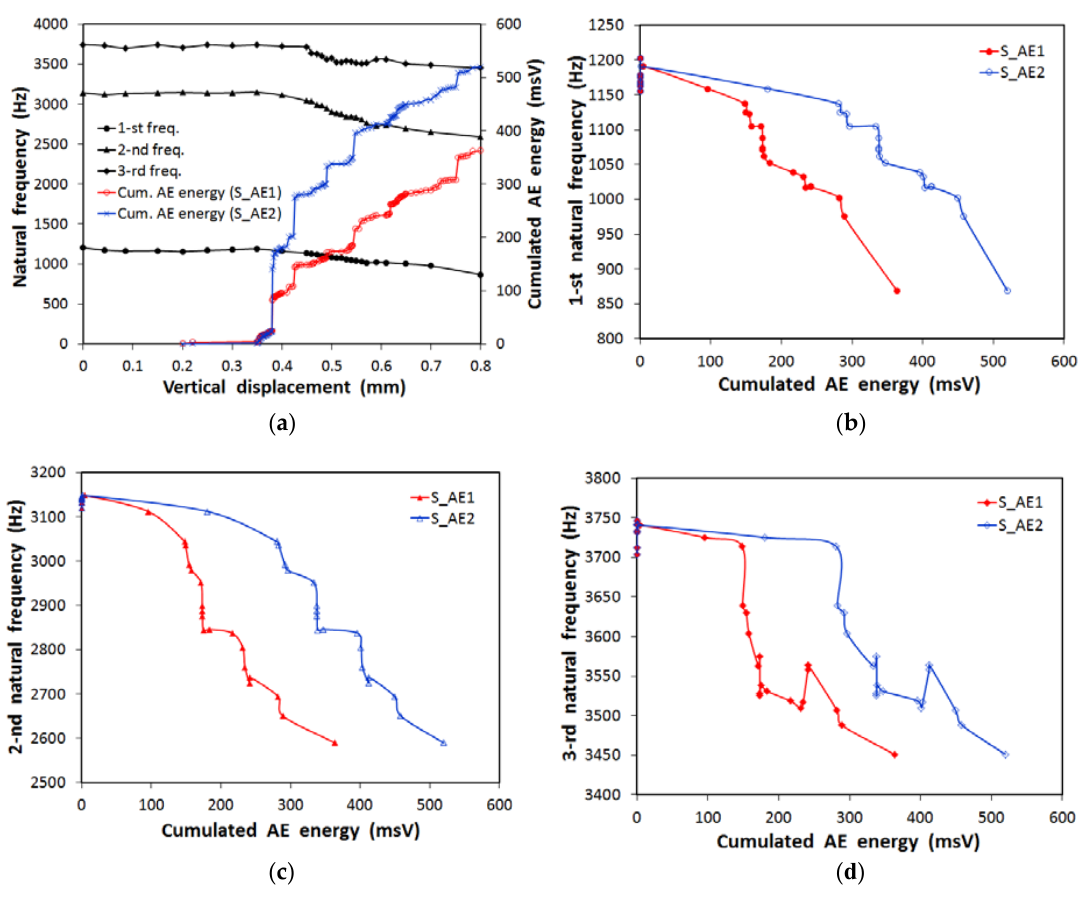
Figure 10. Test 1: ( a ) experimental natural frequencies and cumulated AE energy vs. vertical displacement; ( b – d ) first, second, third natural frequency vs. cumulated AE energy (S AE1 = wideband sensor, S AE2 = resonant sensor).